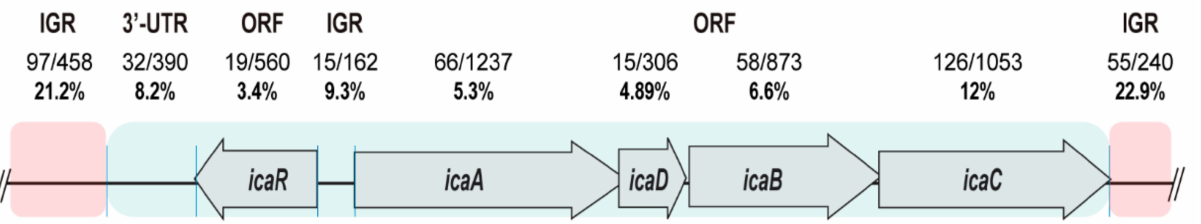
Figure 1. Analysis of nucleotide variation rates along the icaADBCR locus. The 3 (cid:48) UTR of icaR and the icaR - icaA IGR show nucleotide variation rates similar to ica coding sequences. The flanking IGRs, highlighted in red boxes, show high variation rates. The nucleotide variation rate in each region was calculated using 1000 genomic sequences available at the NCBI web page and the percentage represents the ratio between the total number of nucleotide changes in at least one S. aureus genome, and the length of the analysed sequence. ORF, open reading frame; IGR, intergenic